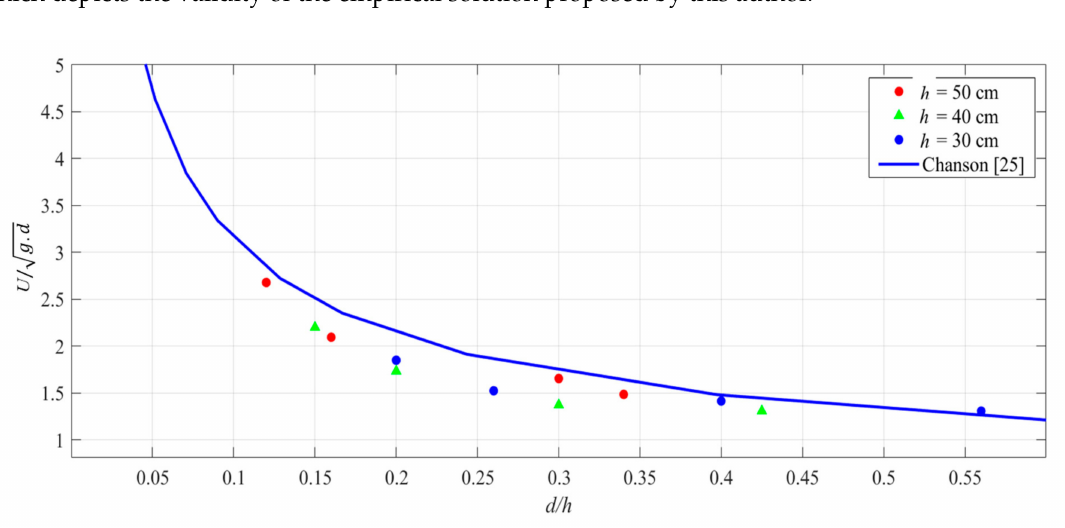
Figure 11. Bore front celerity d / h . The solid line shows Chanson [25] solution (Equation (6)), while the points show experimental